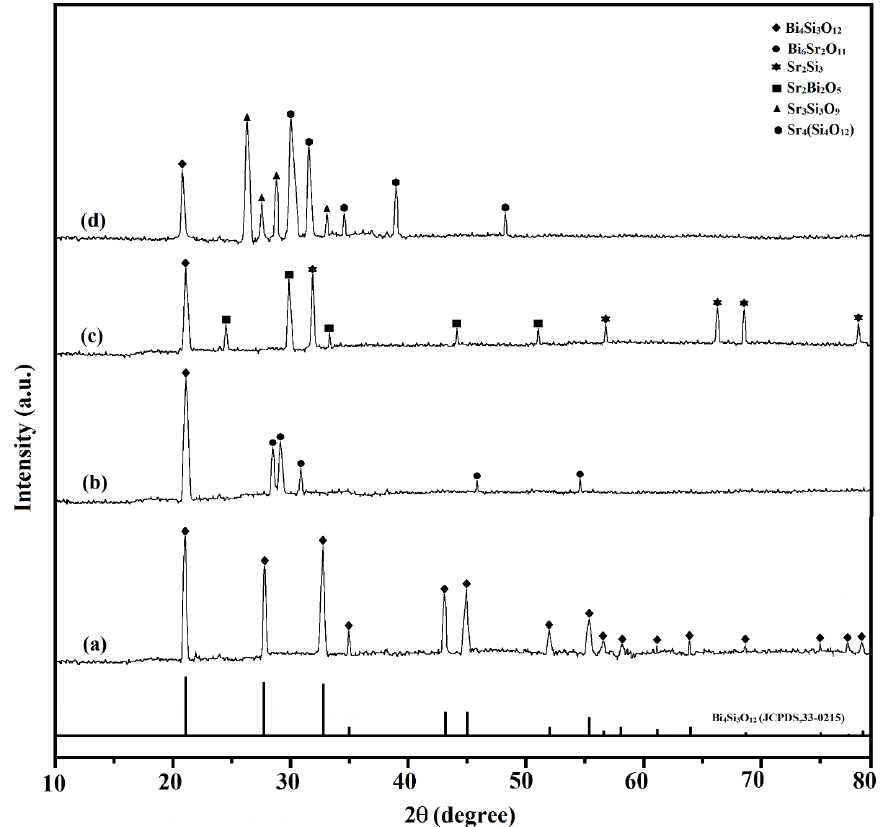
Fig. 4. XRD patterns of (a) BSO, (b) BSS1, (c) BSS2 and (d) BSS3 thin